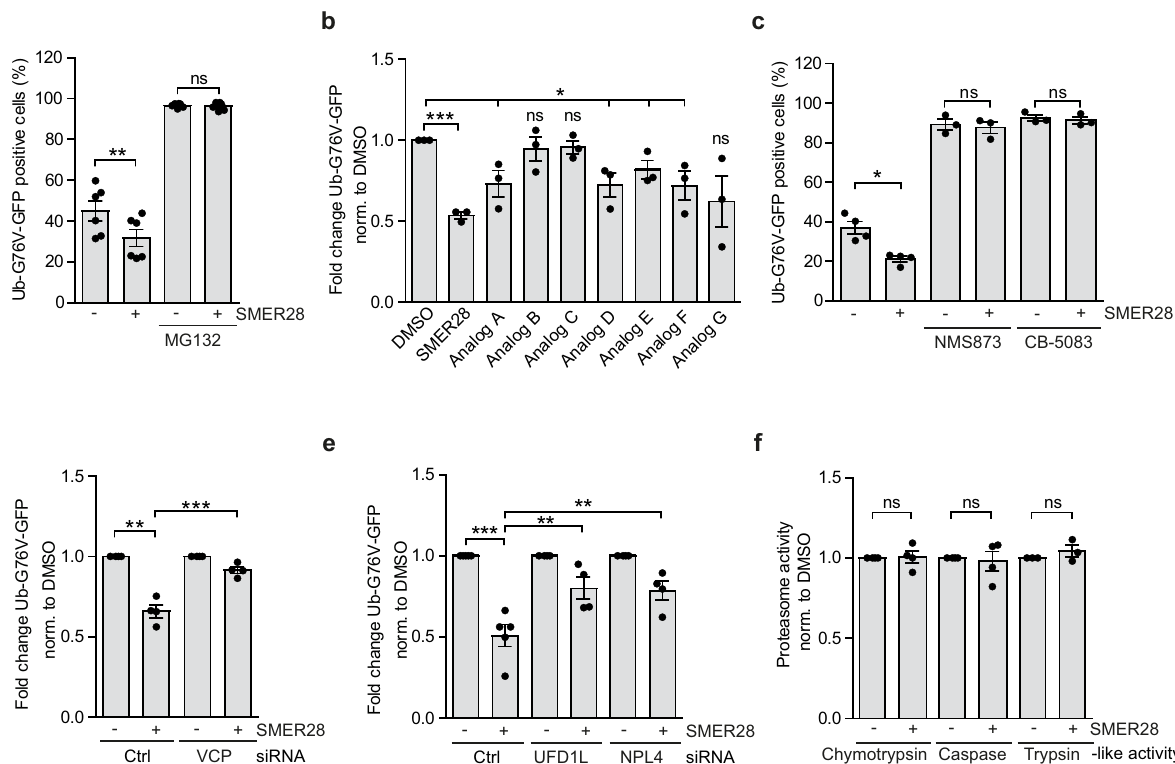
Fig. 6 VCP activation by SMER28 enhances UPS fl ux. a HeLa cells stably expressing Ub-G76V-GFP were treated with 20 µ M SMER28 with or without 5 µ M MG132 for 6 h, followed by FACS analysis, n = 6, paired two-tailed Student ’ s t test; DMSO P = 0.0006; MG132 P = 0.3509. b HeLa cells stably expressing Ub-G76V-GFP were treated with 20 µ M SMER28 or its analogs for 6 h, followed by FACS analysis; unpaired two-tailed Student ’ s t test, n = 3; SMER28 P = 0.00002, A P = 0.03, B P = 0.5516, C P = 0.3542, D P = 0.0214, E P = 0.0337, F P = 0.0344, G P = 0.748. c HeLa cells stably expressing Ub- G76V-GFP were treated with 20 µ M SMER28 with or without 10 µ M NMS873 and 5 µ M CB-5083 for 6 h, followed by FACS analysis, n = 4; paired two- tailed Student ’ s t test; DMSO P = 0.0089, NMS873 P = 0.4895, CB-5083 P = 0.0319. d , e HeLa cells stably expressing Ub-G76V-GFP were treated with siRNA against VCP ( d n = 4) and siRNA against UFD1L or NPL4 ( e n = 5). Raw data comparing effect of the knockdown in Supplementary Fig 5h. After 48 h cells were treated with 20 µ M SMER28 or DMSO for 6 h, followed by FACS analysis; data normalized to DMSO control across all samples to allow comparison of SMER28 effect sizes within and between control and siRNA treated cells; statistical analysis for d , e one-way ANOVA: P < 0.0001 with post hoc Tukey test P < 0.0001. f Proteasome activity. HeLa cells were treated with 20 µ M SMER28 or DMSO for 6 h, lysed and chymotrypsin-like, caspase-like and trypsin-like proteasome activities were measured using fl uorogenic peptide substrates, n = 4; one sample t test. Data in bar graphs presented